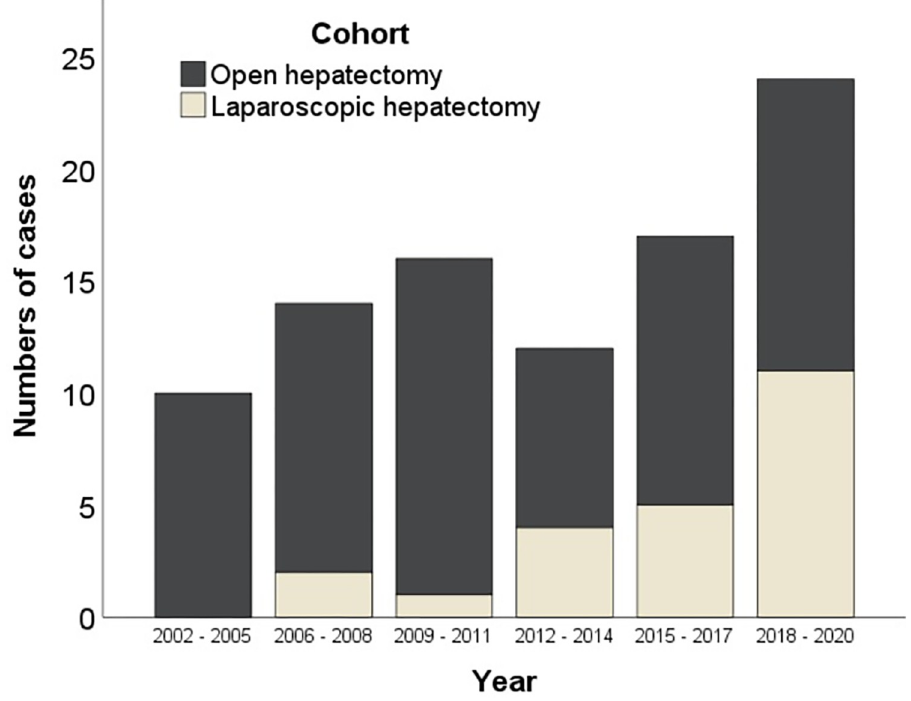
Fig 1. Development of caseload in AE